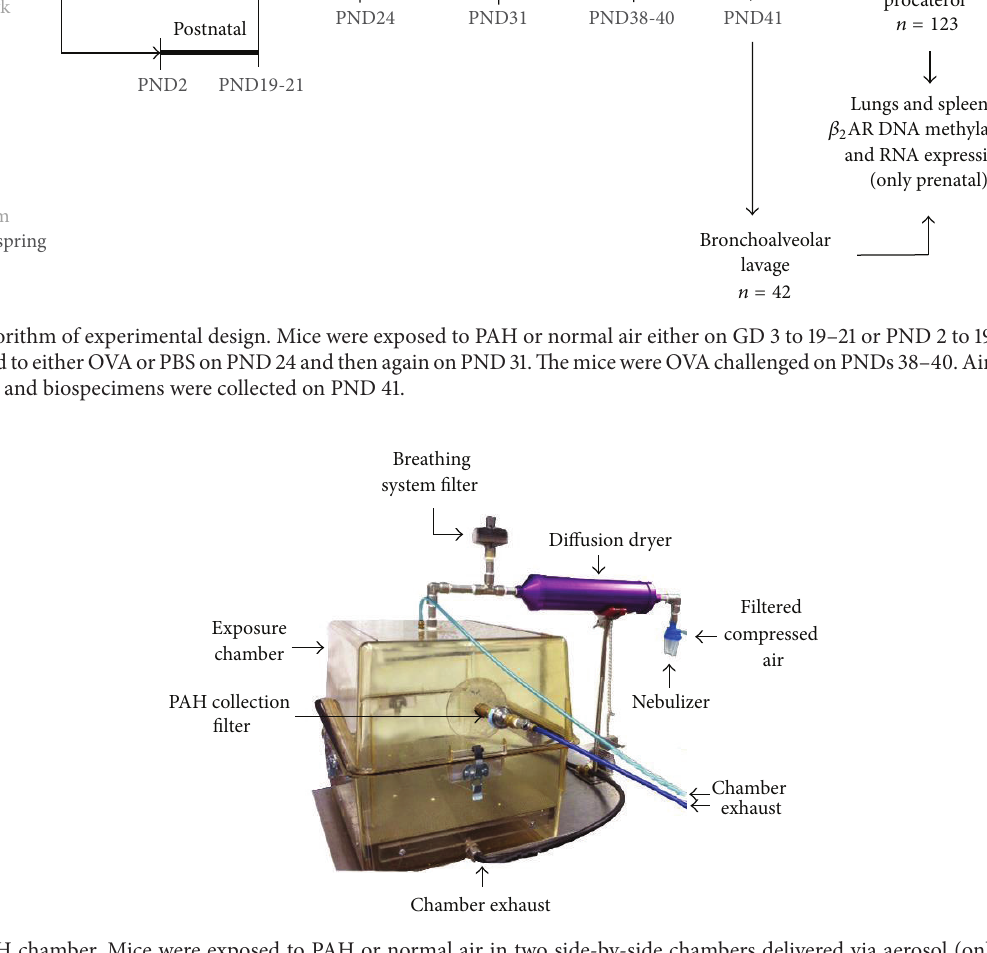
Figure 2: PAH chamber. Mice were exposed to PAH or normal air in two side-by-side chambers delivered via aerosol (only one shown). Filters were collected as depicted and used to measure ambient